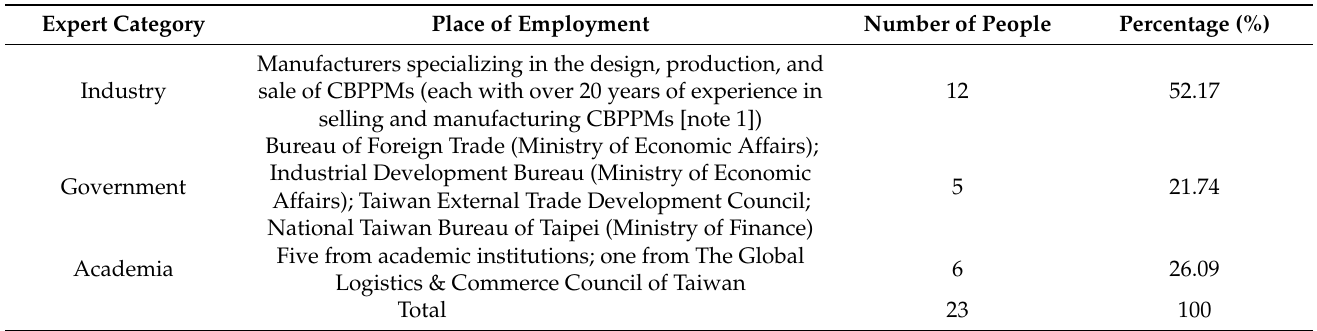
Table 2. Composition of the expert panel.